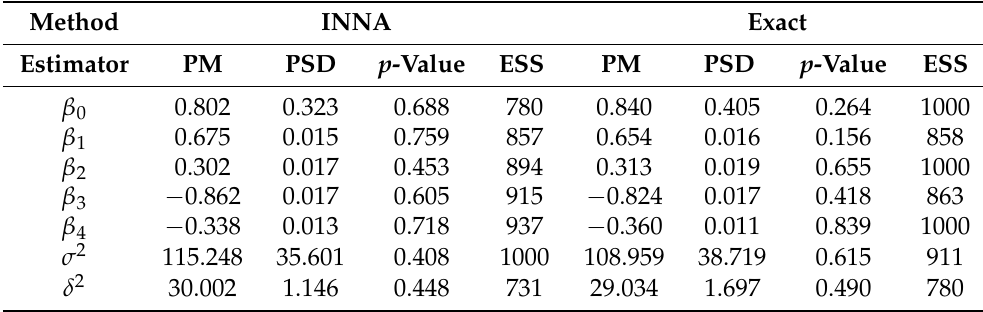
Table 3. Posterior means (PM), associated posterior standard deviations (PSD), Geweke test p -values and effective sample sizes (ESS) of hyperparameters based on the INNA and exact method.